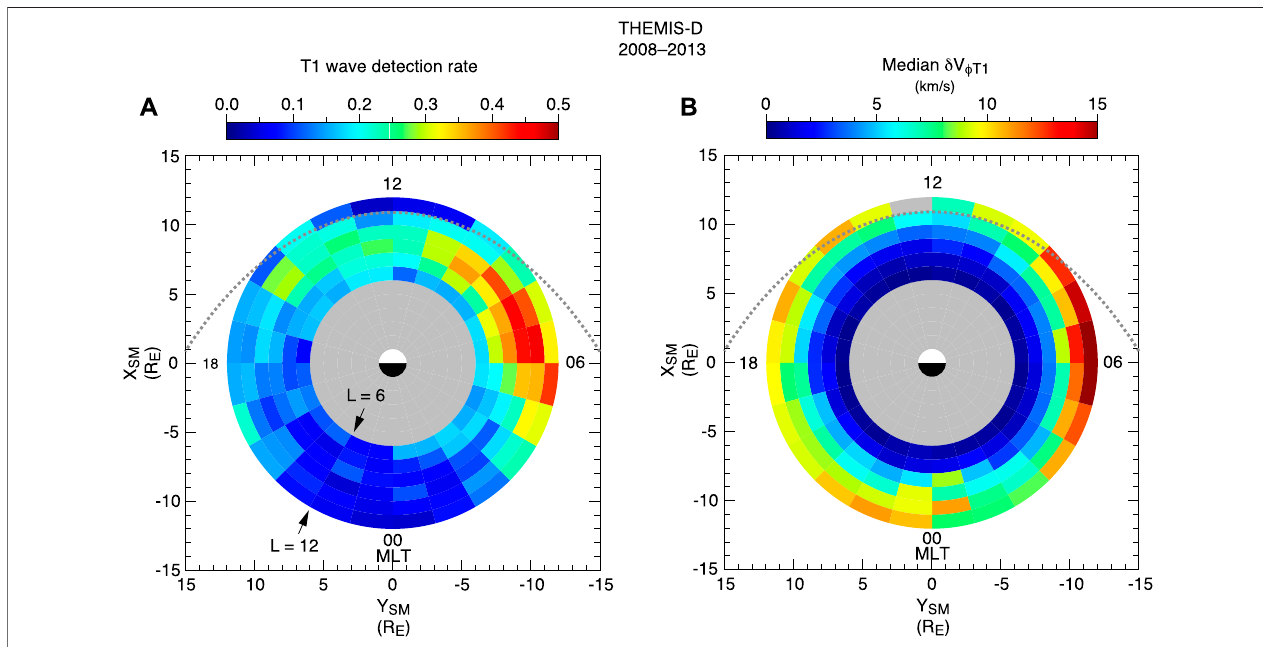
FIGURE10| L -MLTmapsoffundamentaltoroidalwavesdetectedintheionbulkvelocitymeasuredbyTHEMIS-D (afterTakahashietal.,2015b).Thedottedlineis a model magnetopause. (A) Rate of detection. (B) Median amplitude.